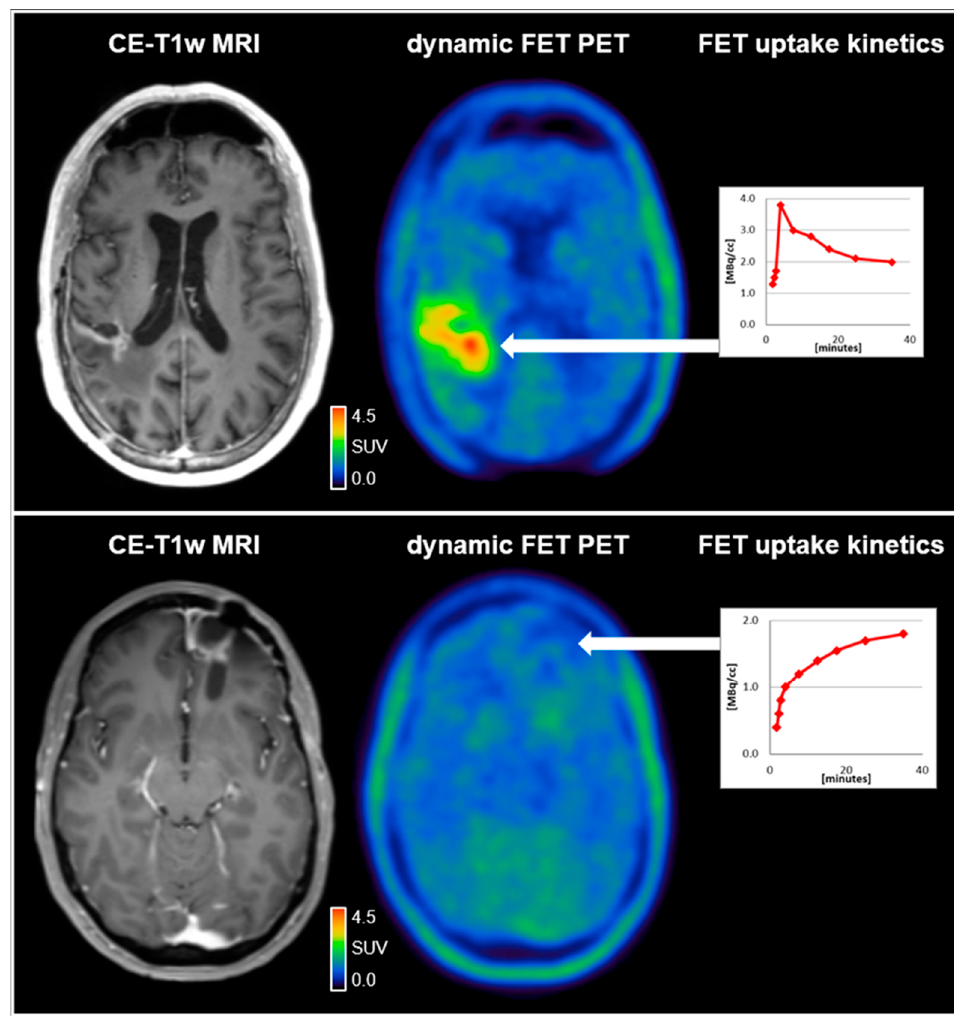
Figure 1. ( upper row ) A 59-year-old male patient diagnosed with an IDH-wild-type glioblastoma (WHO CNS grade 4). Following resection and chemoradiation with temozolomide, the contrast-enhanced MRI (CE-T1w MRI) suggested tumor relapse in the right parietal region 7 months after completing radiotherapy. Accordingly, the dynamic FET PET scan revealed pathologically increased FET uptake right parietal (TBR max , 4.2) and decreased time–activity curve; ( lower row ). A 37-year-old female patient diagnosed with an IDH-wild-type glioblastoma (WHO CNS grade 4). Following resection and chemoradiation with temozolomide, the contrast-enhanced MRI suggested tumor relapse in the left frontal region 7 months after completing radiotherapy. In contrast to the patient in the upper row, the FET uptake in the left frontal region was not pathologically increased (TBR max , 1.6) with a steadily increasing time–activity curve, indicating reactive treatment-related changes. SUV = standardized uptake value.